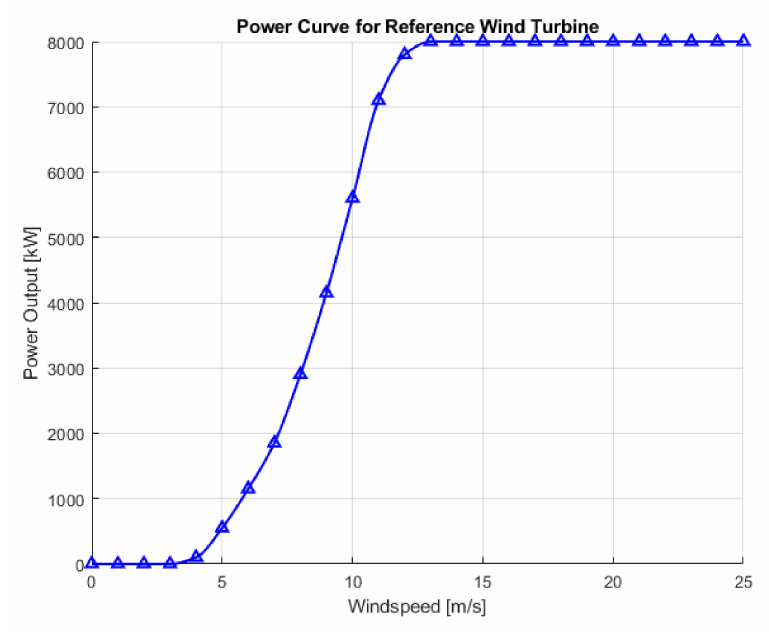
Figure 8. Power curve for reference wind turbine. Adapted from